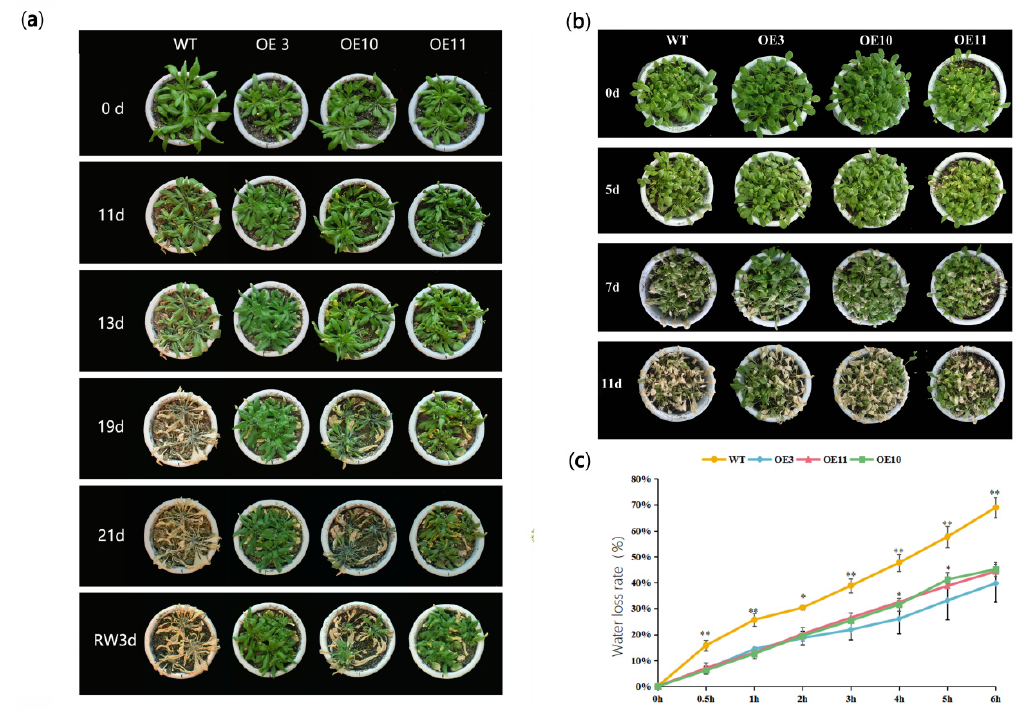
Figure 4. Analysis of OE lines and wild type (WT) upon drought and salinity stress at the adult stage. ( a , b ) Morphology of OE lines and WT plants growing under drought and salinity treatment. ( c ) Water loss rates of leaves in vitro measured at room-temperature of 25 ◦ C. Data are presented as mean and SD values of three independent experiments. Asterisks indicate significant differences (* p < 0.05, ** p < 0.01, by Student’s t -test) compared to WT.